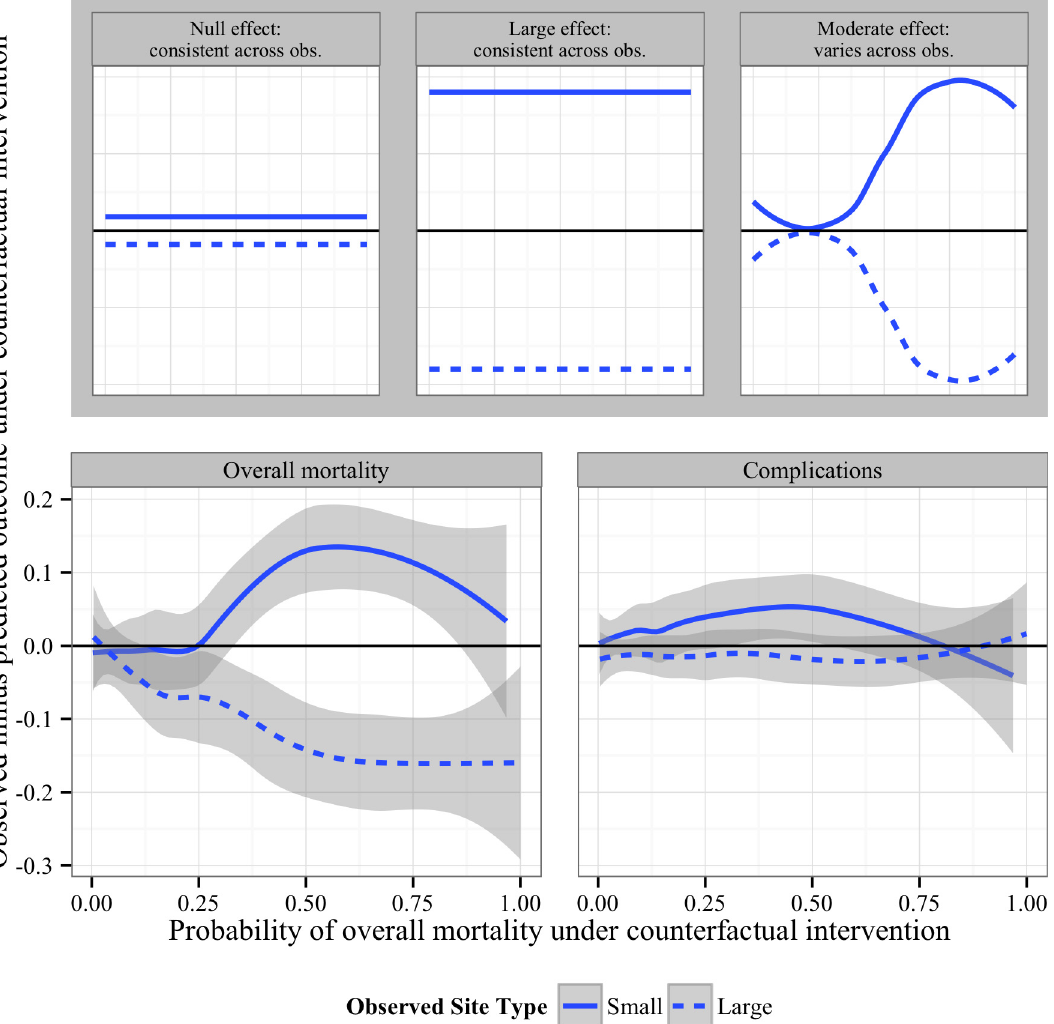
Fig 1. “ Counterfactual ” residual plot for binary outcomes. Residuals (see Diagnostics ) for each outcome were plotted against probabilities of overall mortality for large (dotted line) and small-volume (solid line) site patients for binary outcomes using loess